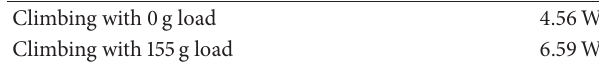
Table 1: Movable load during vertical movement. Table 2: Electric power consumption. Climbing with 0g load 4.56 W Climbing with 155 g load 6.59 W